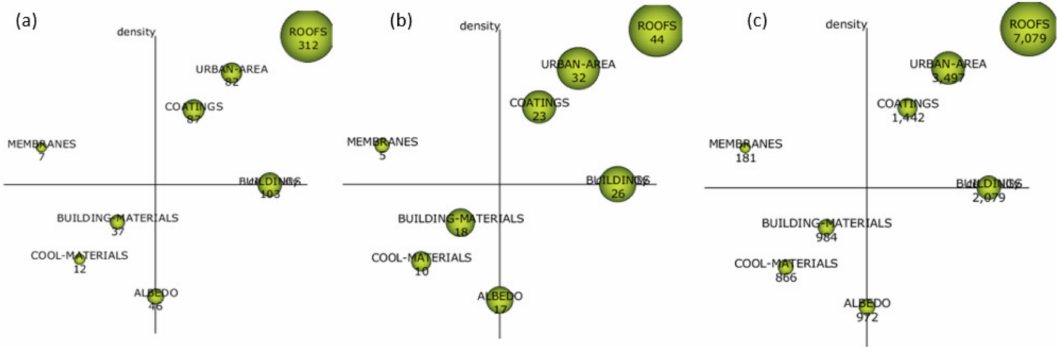
Figure 7. Strategic diagram of the third period, the volume of the spheres is proportional to the number of documents published ( a ), to the h-index ( b ) and to the number of citations ( c ) in the third period associated with each